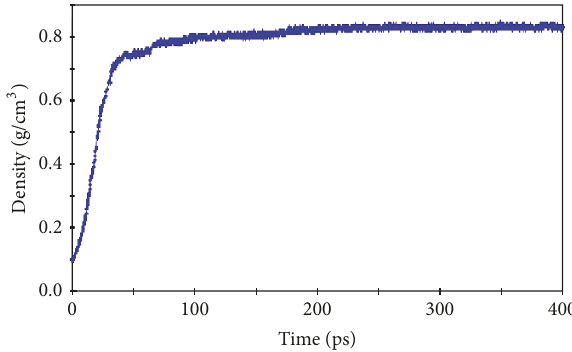
Figure 11: Change of system density with time at 0.02